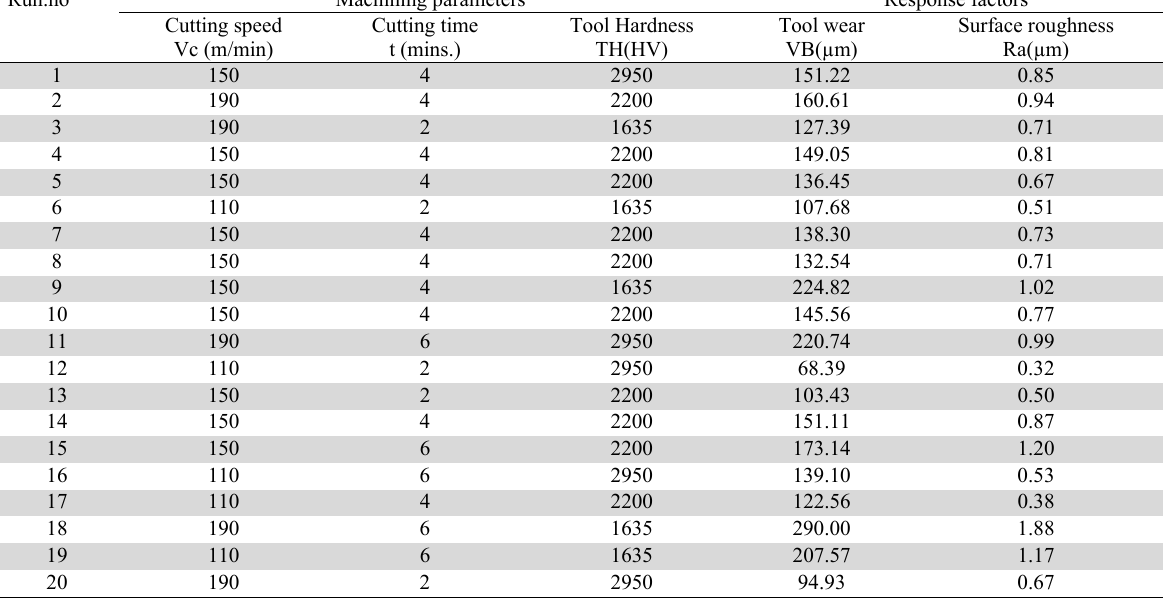
Experimental results for tool wear and surface roughness parameters Run.no Machining parameters Response factors Cutting speed Cutting time Vc (m/min) t (mins.)